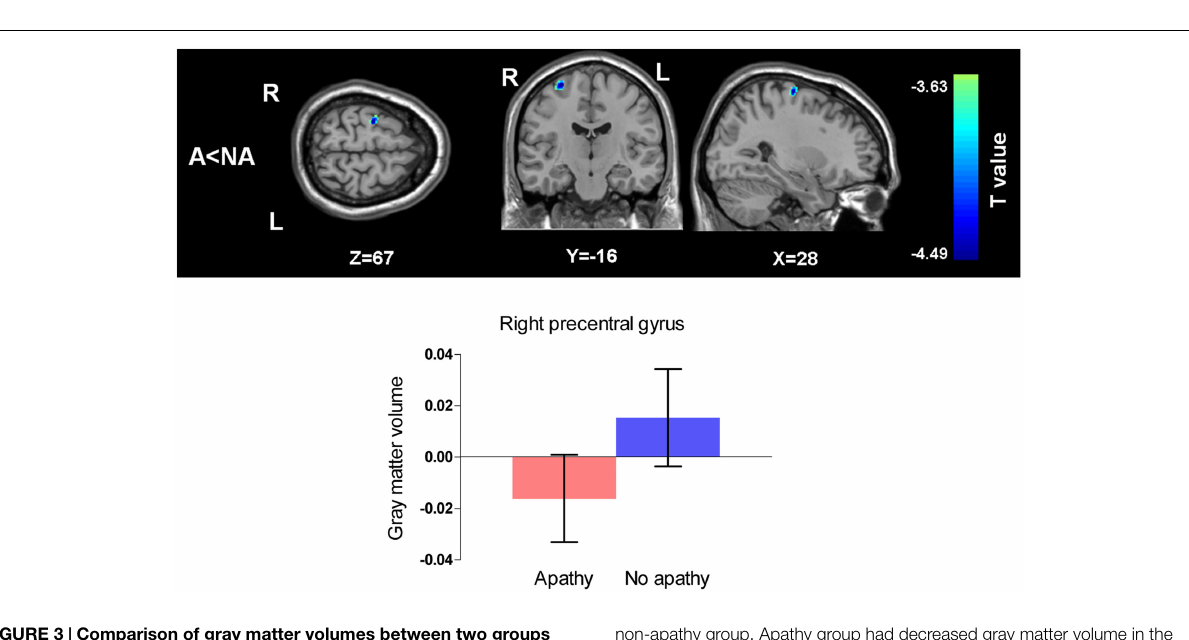
FIGURE 3 | Comparison of gray matter volumes between two groups with SDS scores as a covariate of no interest . (Threshold at p uncorrected < 0.001 and voxels more than 100). A, apathy group; NA,